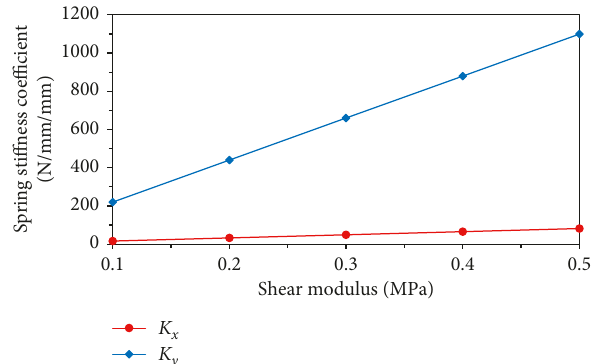
Figure 17: Effect of the shear modulus of the isolation material on the isolation layer spring stiffness.